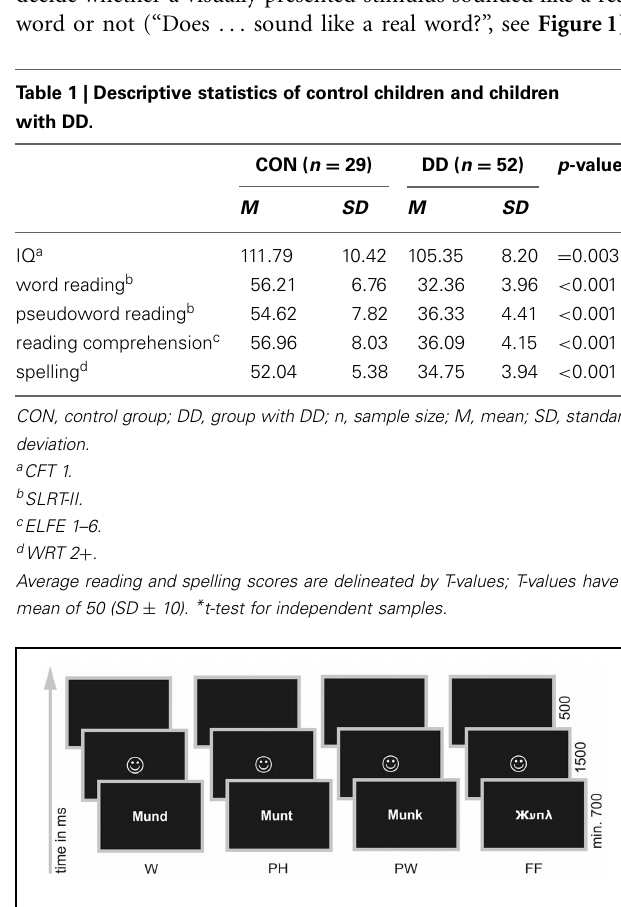
FIGURE 1 | Phonological lexical decision task. Words (W; e.g., Mund /m (cid:2) nt/, engl.: mouth), pseudohomophones (PH; e.g., Munt /m (cid:2)